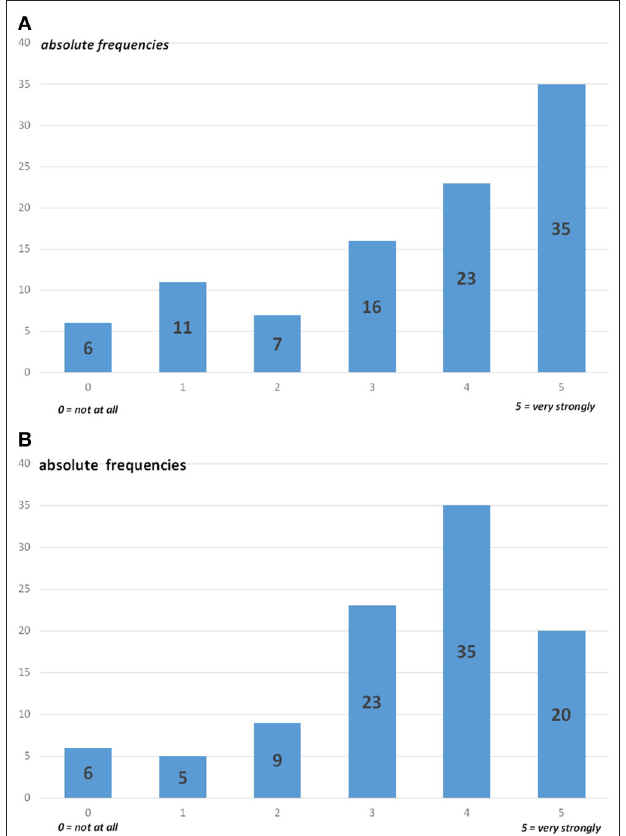
FIGURE 3 | Structures developed for the somatic care of COVID-19 patients. (A) Hospital wards and units for the treatment of COVID-19 patients ( n = 98). (B) Special structures for somatic care related to COVID-19 established in the hospitals ( n = 98). physicians, 1.7 FTE psychologists, 0.2 FTE social workers,